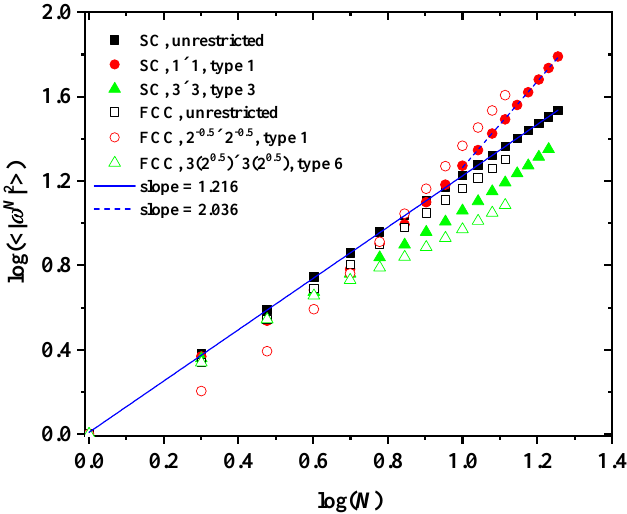
(cid:68)(cid:12) (cid:12) 2 (cid:69) , versus the number of SAW (cid:12) ω N (cid:12)